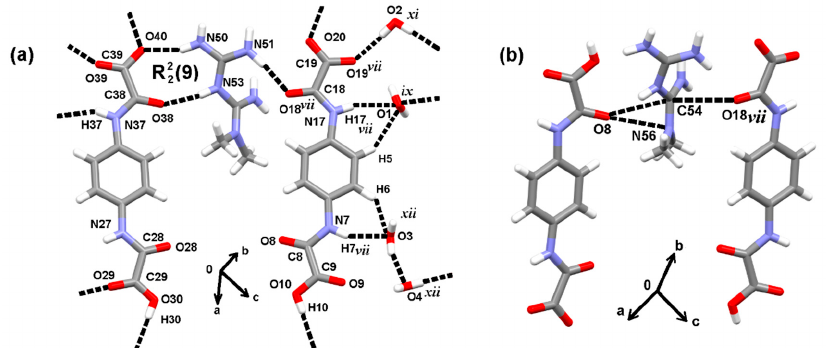
Figure 4. ( a ) Basic repetition unit of the organic salt H 2 Mf(HpOXA) 2 ∙ 4W and atom labelling scheme. ( b ) n → π * charge-assisted interactions between O8 ∙∙∙ C54 ∙∙∙ O18 and O8 ∙∙∙ N56 that contribute to form the duplex by an inversion center of symmetry. See Tables 2 and 3 for symmetry codes. Table 2. Geometric parameters of CO ∙∙∙ A interactions (A = CO, N) in H 2 Mf(HpOXA) ∙ 4W.